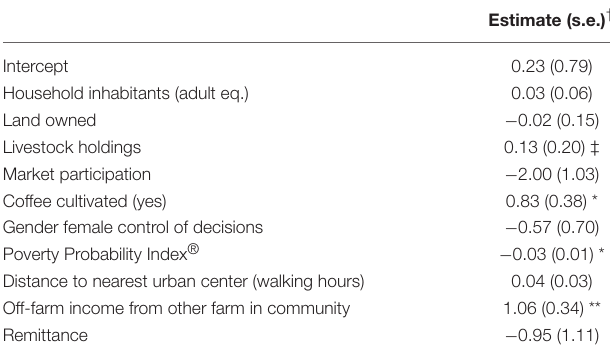
TABLE 4 | Associations of socio-economic indicators with Household Food Insecurity Access Prevalence (HFIAP), logistic regressions using the rural household multiple indicator survey (RHoMIS) output from households in the dry corridor of Guatemala in 2015.